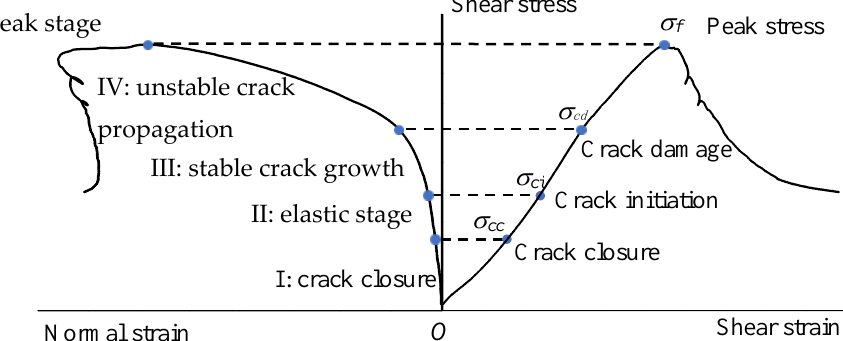
Figure 6. Division of different stress-strain stages of the granite samples under direct shear test.